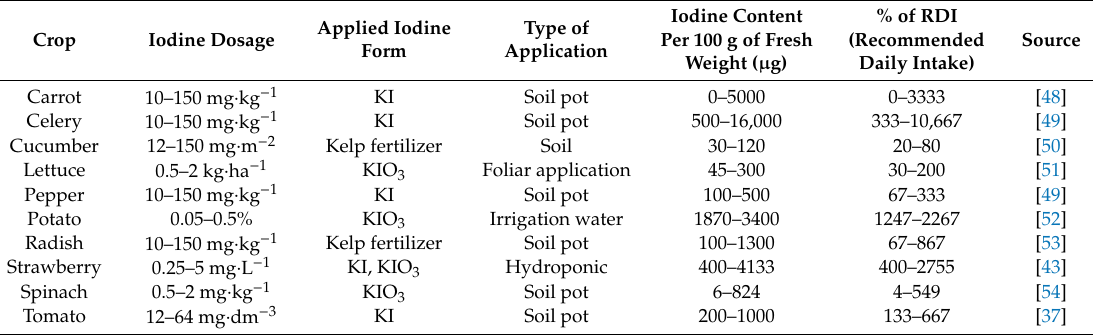
Table 5. List of studies on iodine biofortification of crops and the respective bioaccumulation e ffi ciency related to the recommended daily intake per 100 g of fresh